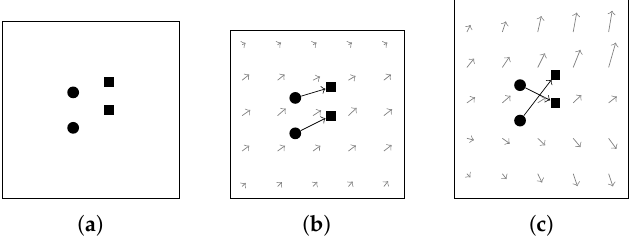
Figure 4. Illustration of the velocity field. ( a ): two given point pairs. ( b ): a coherent velocity field. ( c ): a velocity field that is less coherent.